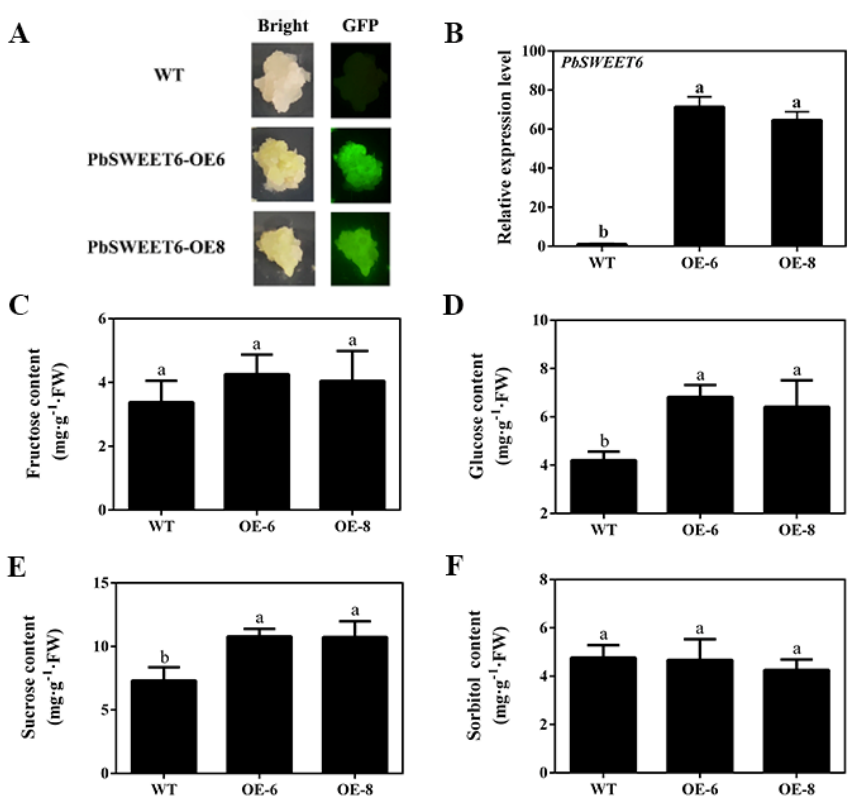
Figure 5. Fruit quality determination in wild type and PbSWEET6 -OE tomato. ( A ) Fruits of wild type and PbSWEET6 -OE lines at the red mature fruit stage; the scale bars correspond to 1 cm. ( B ) Single fruit weight. ( C - F ) The SSC and soluble sugar (fructose, glucose, and sucrose) contents in red mature fruits of the WT and PbSWEET6 -OE lines. The data represent the mean values ± SDs. Differ- ent letters represent significant differences (Tukey’s HSD, p < 0.05).